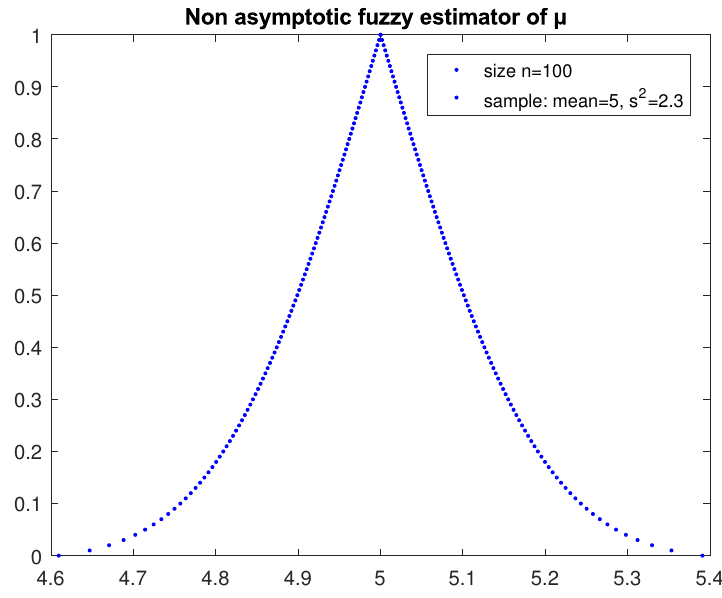
Figure 2. The possibility distribution of the fuzzy estimator (cid:101) µ of the mean µ of a random variable X , which follows normal distribution with variance σ 2 = 2.3 derived from a sample of n = 100 observations with sample mean x =